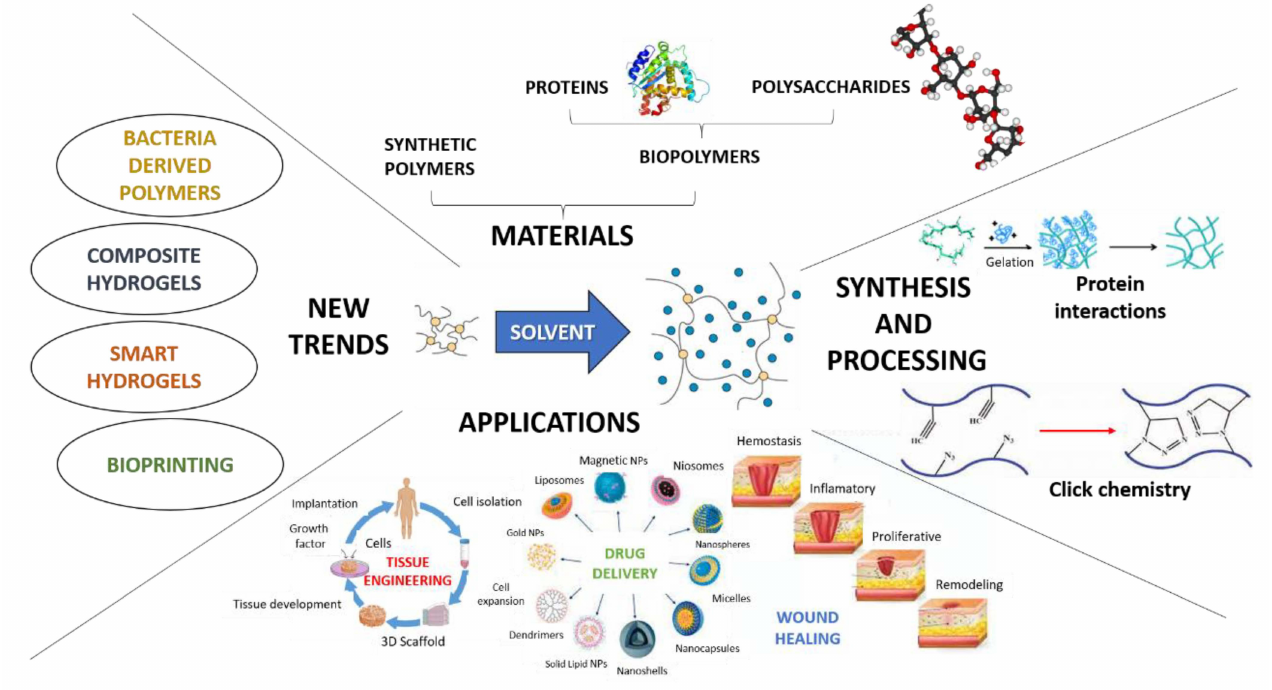
Figure 1. General perspective of the present and recent trends of hydrogels research in the biomedical field.